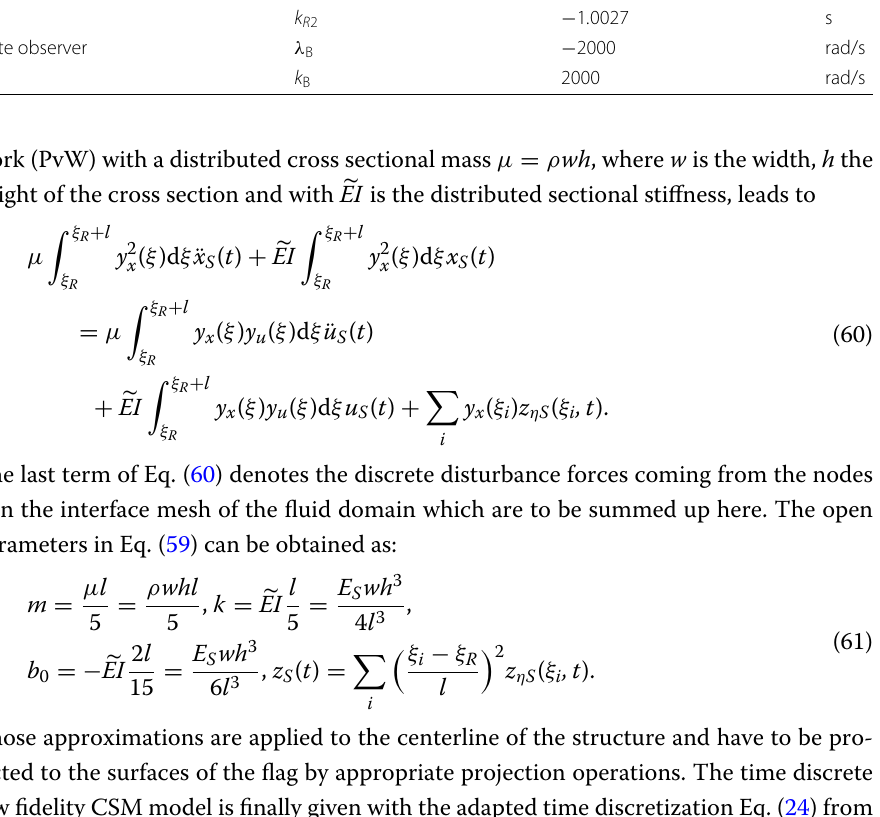
Table 1 Values selected for controller parameters Component Parameter Value Unit Controlled system m